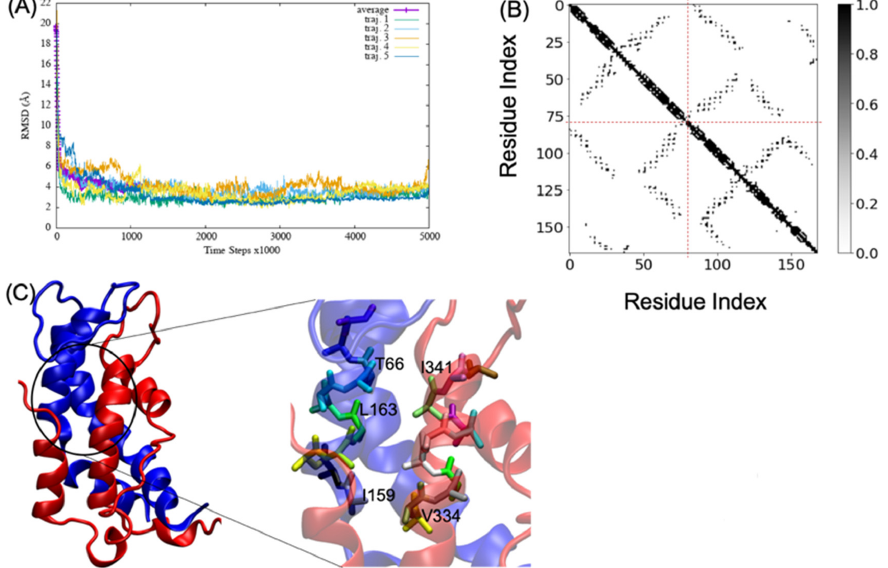
Figure 9. Successful association between the N-terminal domain of D2R and the C-terminal domain of 5-HT2AR. ( A ) shows the root mean square deviation (RMSD) over five trajectories and its average; ( B ) indicates the residue contact maps, the dashed lines limit the two monomers; residues 1 to 79 represent the D2R, and residues 80 through 168 represent 5-HT2AR; ( C ) shows a snapshot of the complex D2R (blue) and 5-HT2AR (red). A few residues at the interacting interface between D2R and 5-HT2AR are zoomed out to showcase their interactions